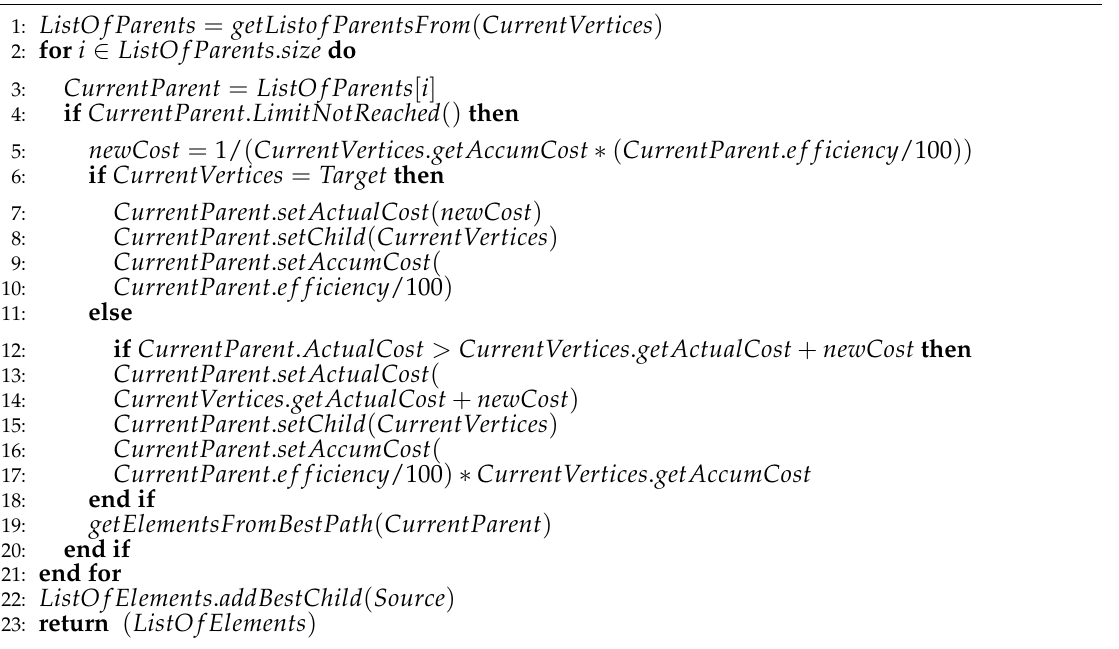
Algorithm 3 Search